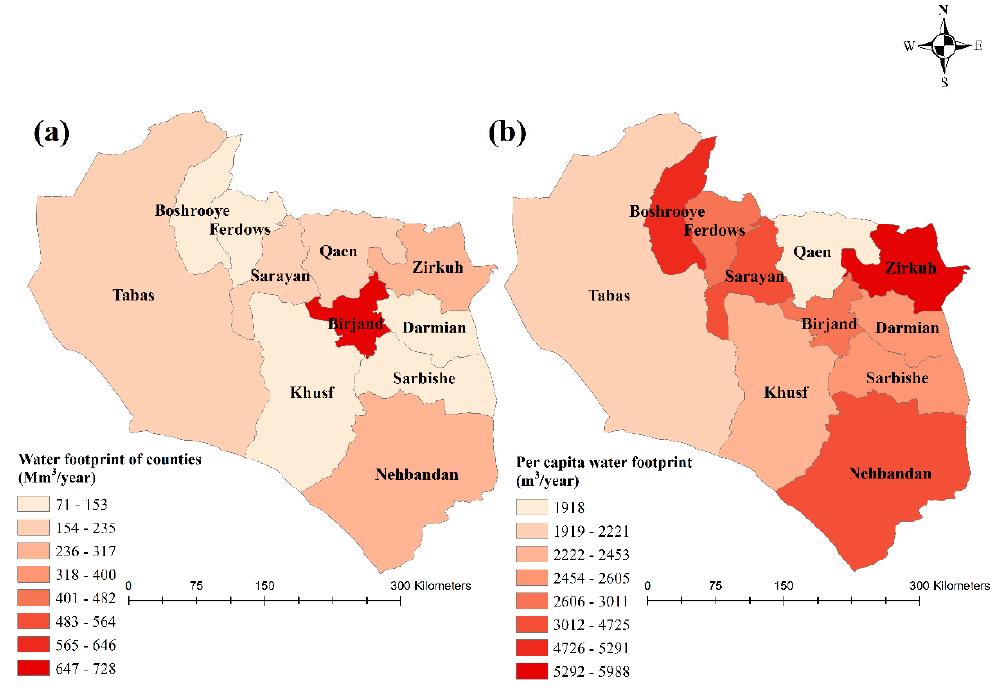
Figure 7. The water footprint of counties ( a ) and per capita water footprint ( b ). Water 2019 , 11 , x FOR PEER REVIEW